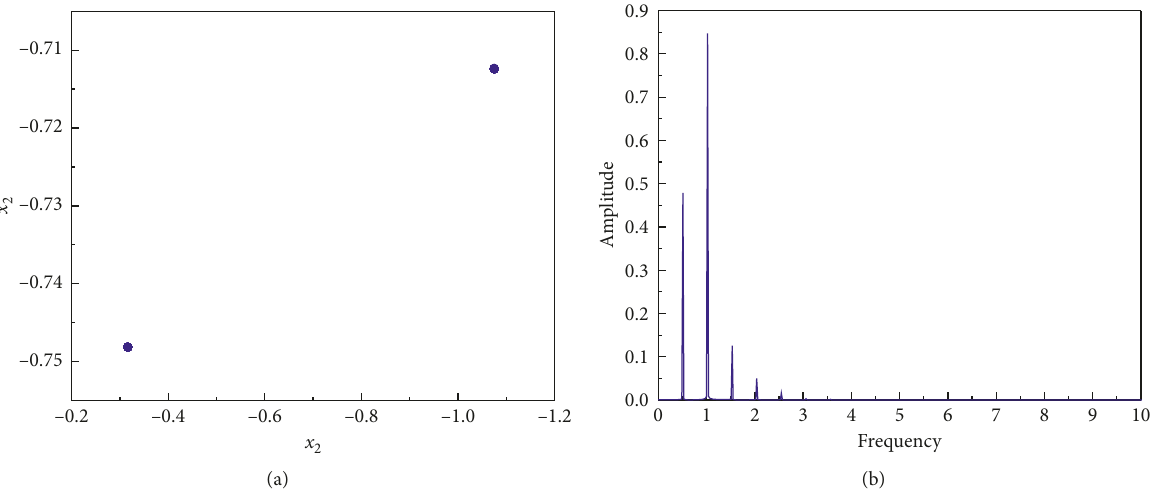
Figure 17: Period-2 motion of the baseplate for Ω � 1 . 02.